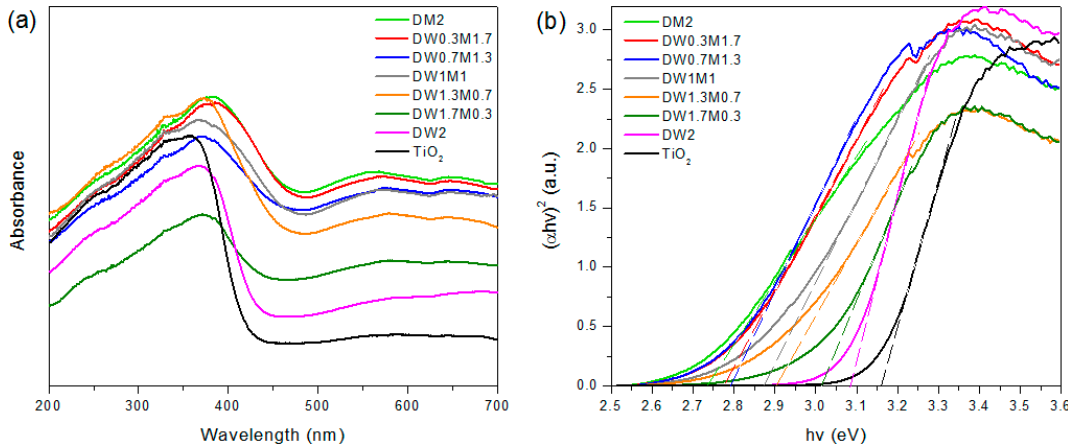
Figure 7. ( a ) UV-vis absorbance spectra and ( b ) band gap energies (Tauc plots) of synthesized catalysts. Table 3. Band gap energy and wavelength of synthesized materials.